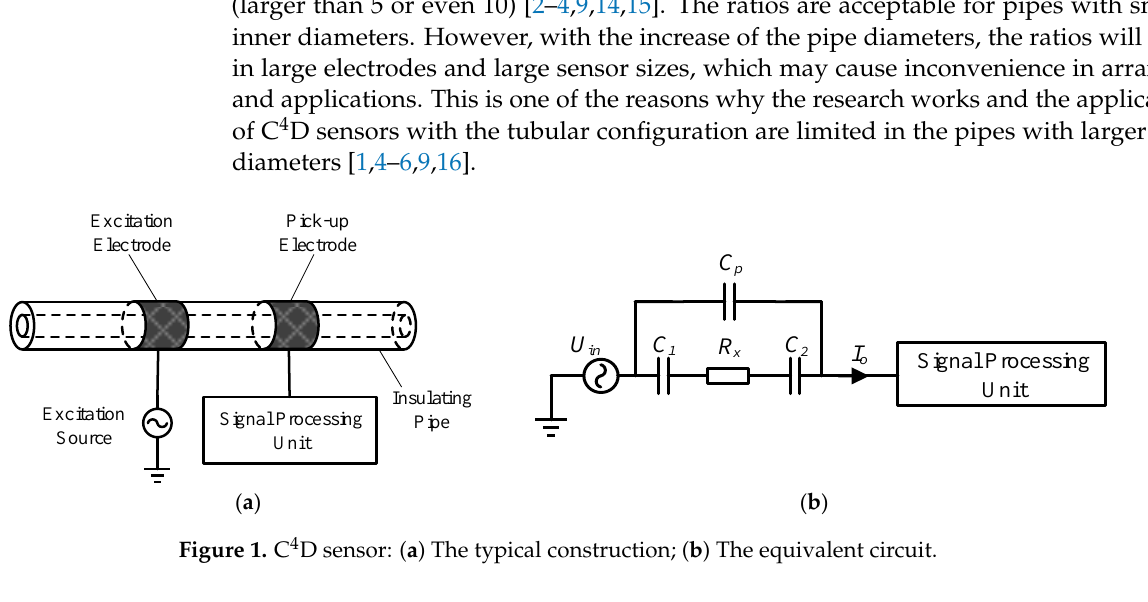
Figure 1. C 4 D sensor: ( a ) The typical construction; ( b ) The equivalent circuit.